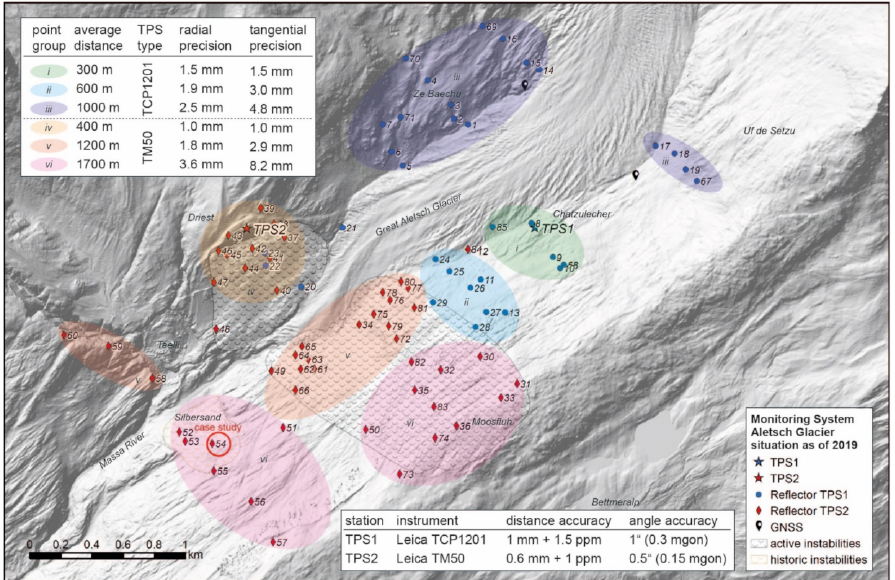
Figure 7. Point groups within the RTS Monitoring area surrounding the Great Aletsch Glacier and expected radial and tangential precision of measurements for the instruments installed at TPS1 (Leica TCP 1201) and TPS2 (Leica TM50) measured in ATR mode.